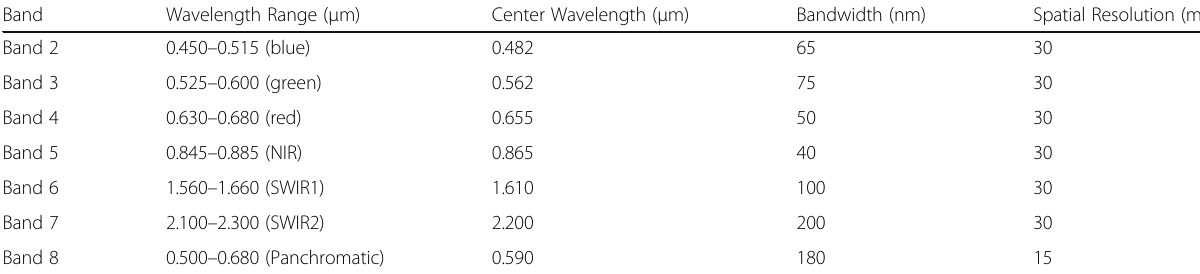
Table 1 Bands, spectral wavelengths, and resolution of Landsat 8 OLI